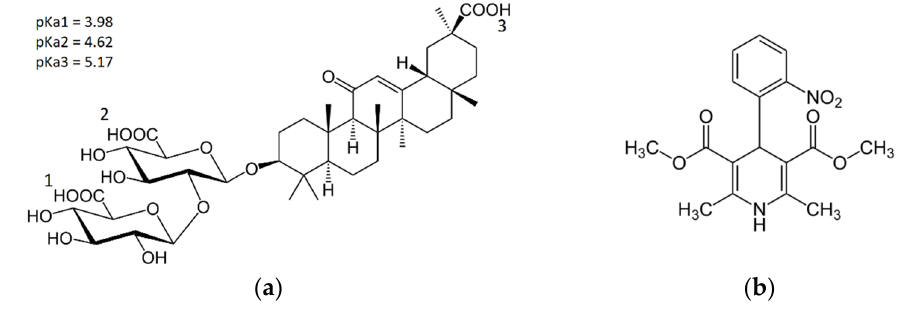
Figure 1. The chemical structure of ( a ) glycyrrhizic acid (GA) and ( b ) nifedipine. It is known that glycyrrhizin forms self-associates (oligomers and micelles) in aque- ous solutions, and its self-association depends on the pH of the media [32–34]. GA has three dissociation steps, with pKa values 3.98, 4.62, and 5.17 (Figure 1a, data is taken from [35]). Deprotonation of GA leads to changes in critical micelle concentration (CMC) values [32,33]. In addition, deprotonation leads to changes in the interactions of GA with lipid bilayers [33]. Therefore, such pH-dependent behavior suggests a possible application of GA as the base of a pH-controlled drug delivery system. In the present work, the properties of supramolecular associates of GA with a drug on the model of the hypotensive and antiarrhythmic drug nifedipine (Figure 1b) have been studied by the methods of nuclear magnetic resonance and molecular dynamics simulations. Earlier, it was found in vivo, that the complexes of GA with nifedipine show a significant increase (more than one order) in its therapeutic activity on the models of adrenaline-induced hypertension and CaCl 2 -induced arrhythmia [36].